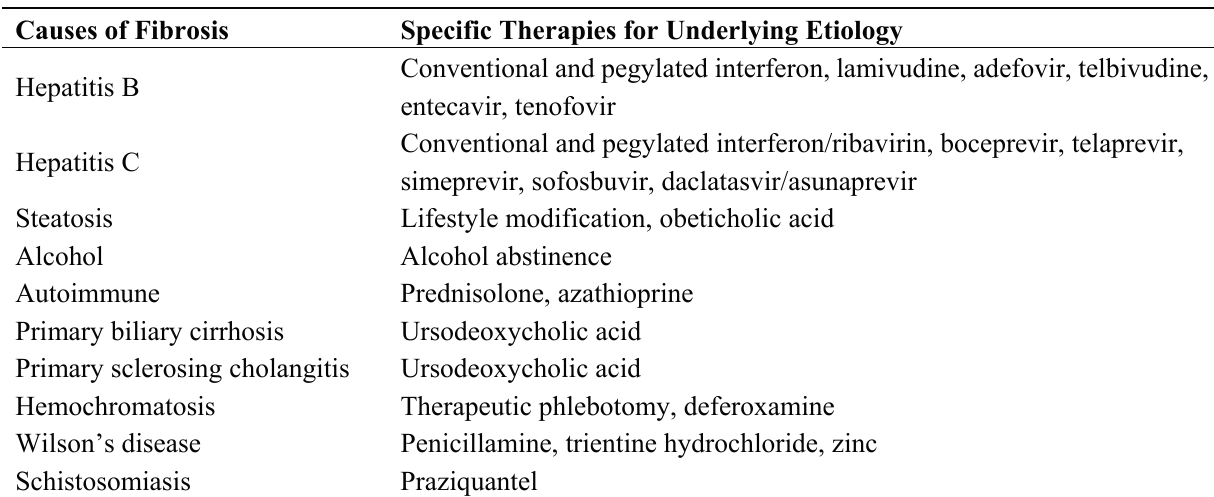
Table 1. Causes of fibrosis and specific therapies for underlying